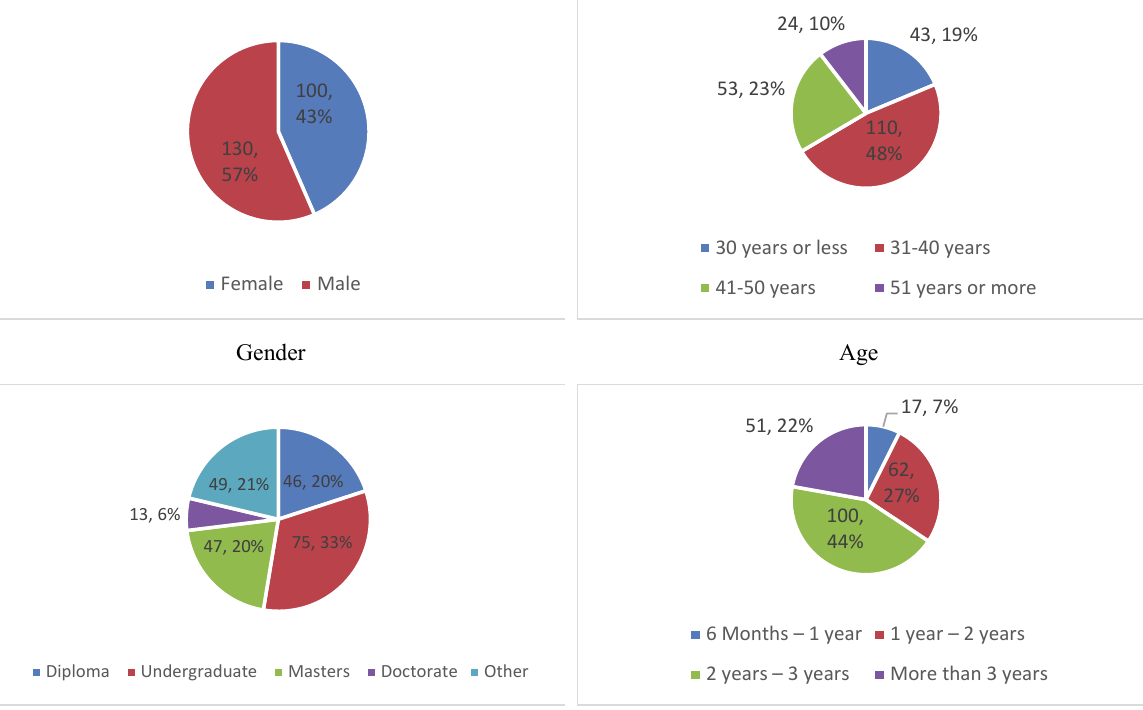
Fig. 2. Personal characteristics of the